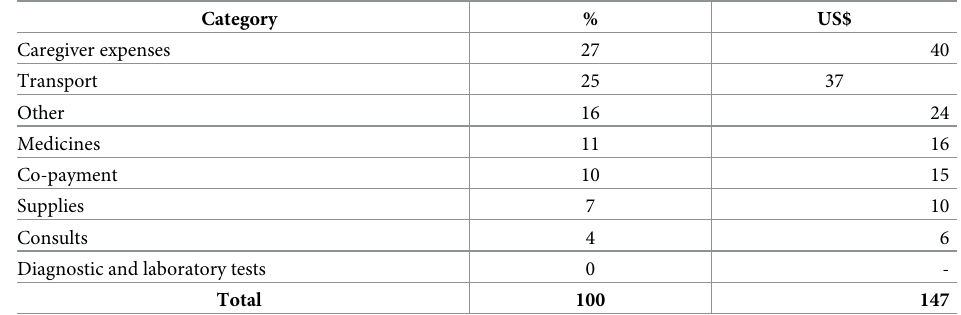
Table 4. Out-of-pocket expenses (OOPE) and indirect costs per item for influenza SARI patient in